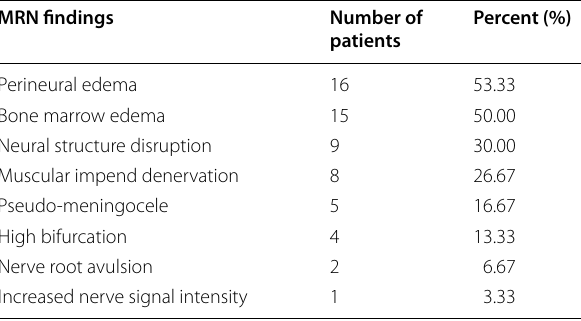
Table 3 Distribution of the studied cases according to additional MRN findings ( n =